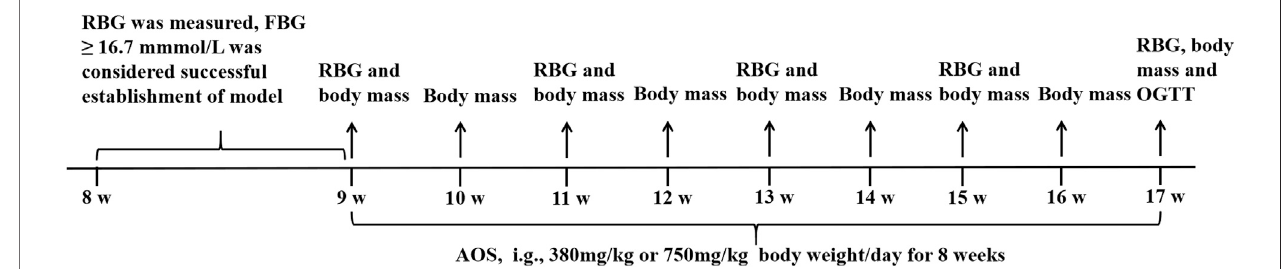
FIGURE1| Experimentaldesignofthe invivo study.Thedb/manddb/db micewerehousedat22 ± 2 ° C,40 – 70%relativehumidityand12-hlight/darkcycle.After 7 days, RBG was measured by snipping the tails. The diabetic mice were randomly divided into Model, AOS (380 or 750 mg/kg/day), and Metformin (160 mg/kg/day) groups. The drug treatment lasted 8 weeks. RBG levels were measured weekly during 8 weeks of AOS and metformin treatment. At the end of the experiments, the mouse were sacri fi ced for further